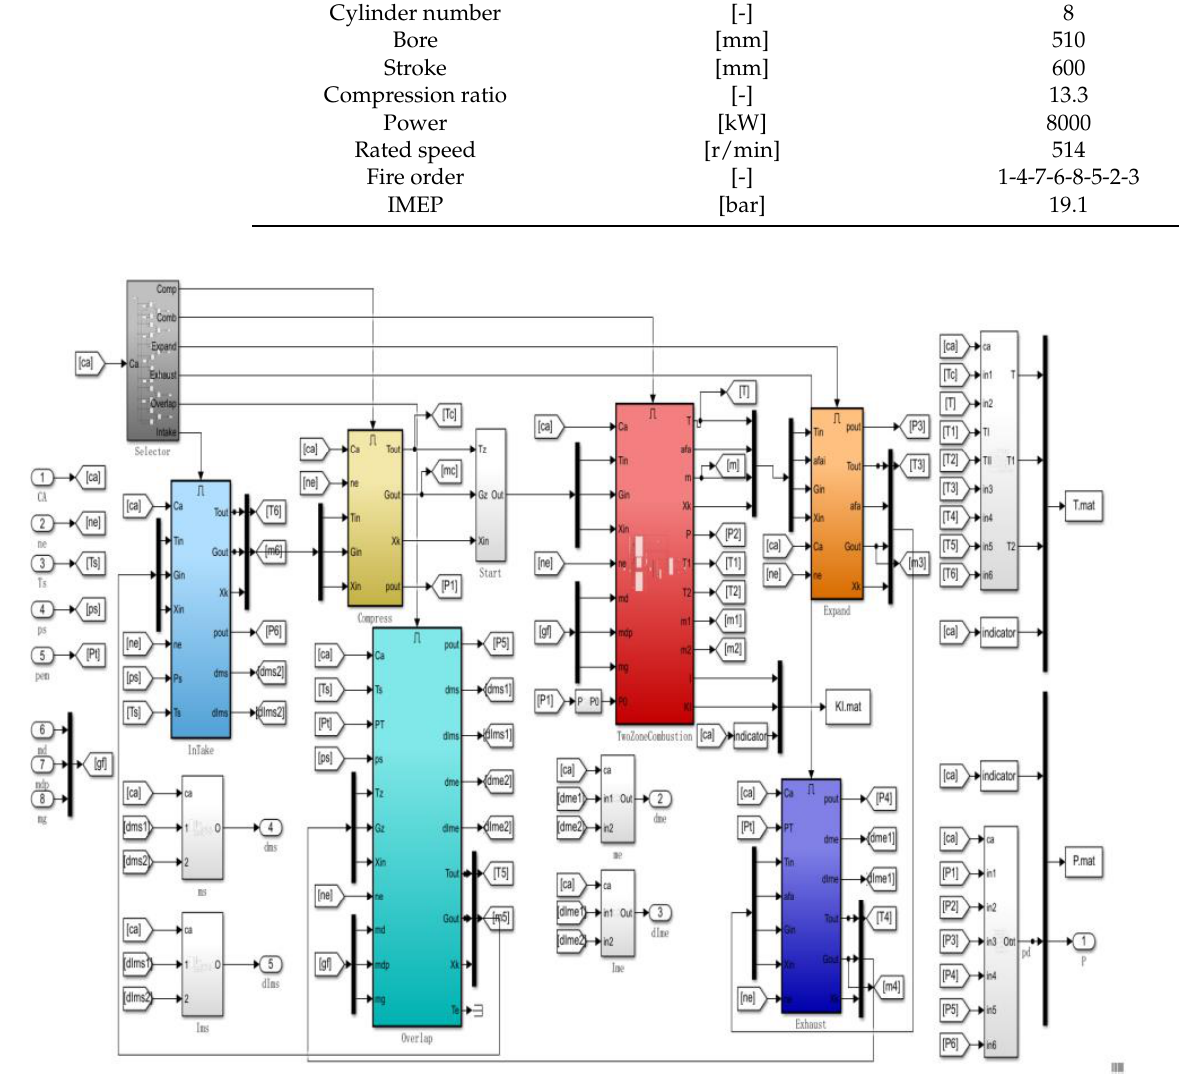
Figure 5. Two-zone simulation model.